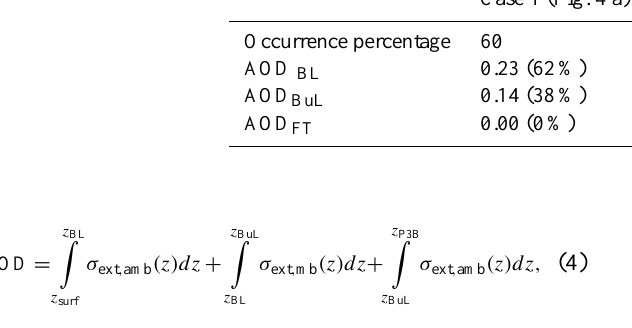
Fig. 4. Profiles ( a , b , c ) of the ambient extinction coefficient (550nm) observed aboard the P-3B over Edgewood on 20, 21 and 28 July 2011, respectively. Time series (d) of the aerosol optical depth (AOD at 550nm, black dots) calculated from the integration over the column of the extinction coefficients measured aboard the P-3B, the PM 2 . 5 measured from the Edgewood ground site (grey line), the mass extinction efficiency (MEE, red dots) and the ratio of the sulphate mass concentration over the water soluble organic mass concentration (blue dots) measured at the lowest level of the P-3B profiles. Table 1. Aerosol optical depth (550nm) calculated for the cases study shown in Fig. 4a, b, c for the boundary layer (BL), the buffer layer (BuL) and the free troposphere above the BuL (FT). The AOD contributions are indicated in the parentheses. Case 1 (Fig. 4 a) Case 2 (Fig. 4b) Case 3 (Fig.